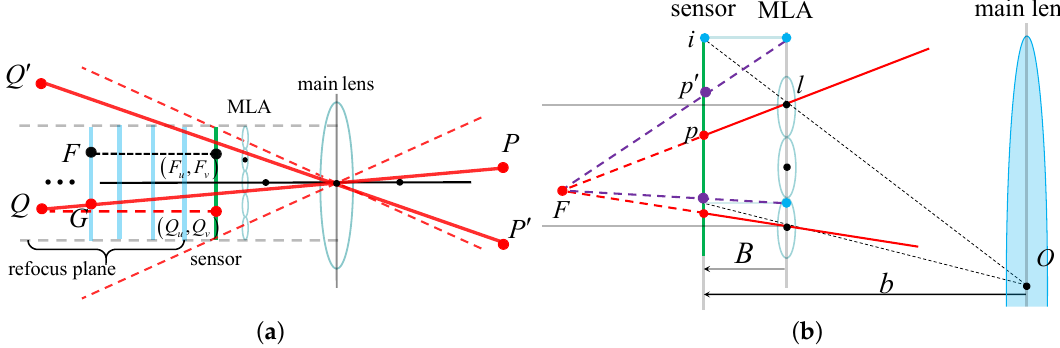
Figure 2. Illustration of traditional refocusing algorithm. ( a ) Traditional refocusing model. ( b ) Illustration of projection